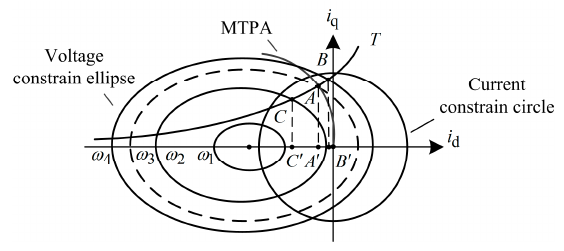
Figure 4. The voltage and current constrains.